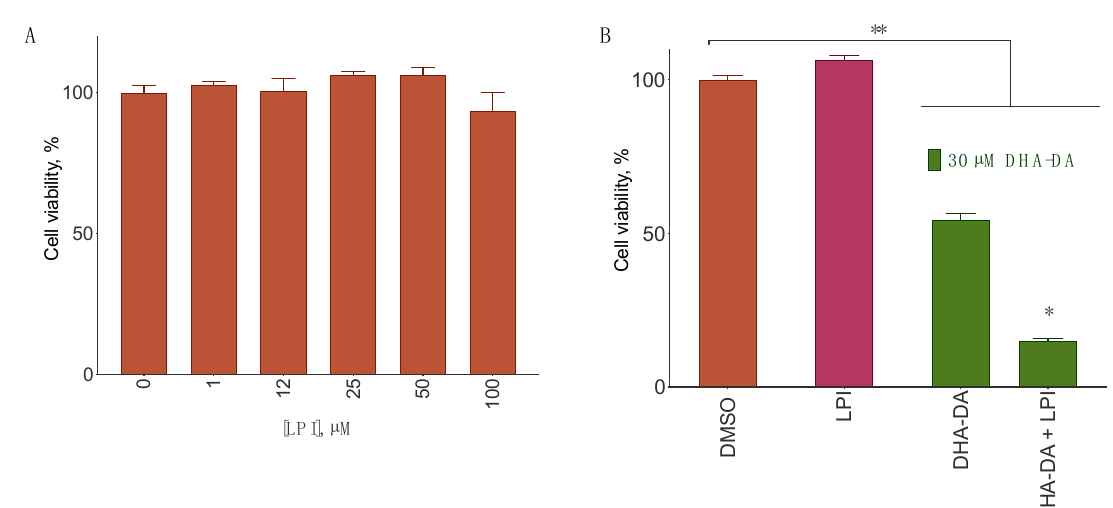
Figure 6. Lysophosphatidyl inositol (LPI) interplay with N -docosahexaenoyl dopamine (DHA-DA) on MDA-MB-231 cells in the cell viability model. ( A ), the influence of LPI on MDA-MB-231 cells viability. ( B ), the influence of LPI (50 µM) on DHA-DA cytotoxicity for MDA-MB-231 cells. 24 h incubation, MTT assay, mean ± S.E., n = 3 experiments. *, a statistically significant difference from the appropriate concentration of DHA-DA alone, **, a statistically significant difference from the DMSO control, ANOVA with the Tukey post-test, p ≤ 0.05.